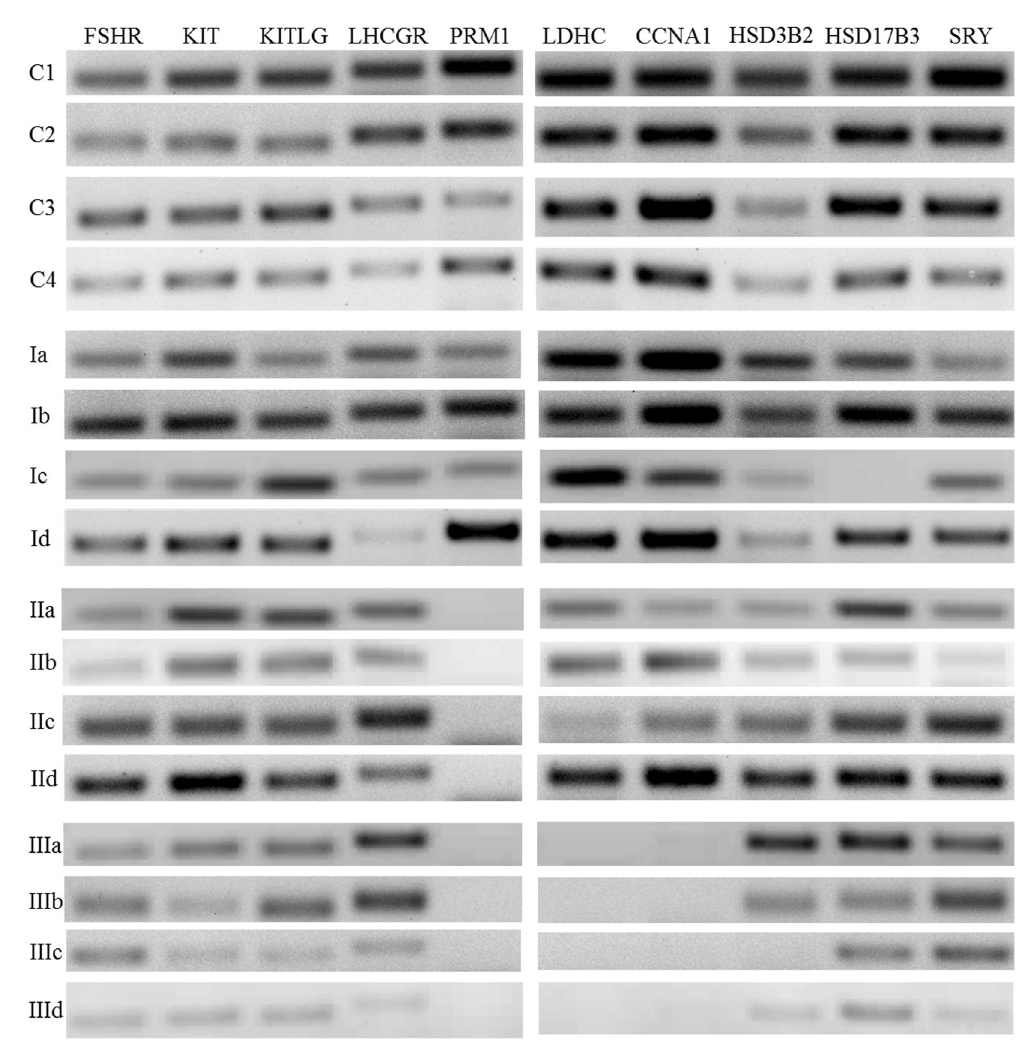
Figure 2. Expression of testicular cell specific marker genes. The expression status of the testicular cell specific markers for each representative patient samples as shown in the Fig. 1 is shown here. The total testicular RNA obtained from tissue samples was converted to cDNA by RT-PCR and the expression of the testicular cell specific markers was analyzed by semi-quantitative PCR using the specific primers. Each patient sample was analyzed individually by PCR for the expression of the testicular cell type specific markers as and when the sample was collected. Cropped images from individual gels are shown. C1–C4: control; I a-d: Group I (obstructive azoospermia, exhibiting haploid, diploid and double-diploid populations); II a-d: Group II - (NOA with meiotic arrest, exhibiting diploid and double-diploid populations); III a-d: Group III (NOA with pre- meiotic arrest, exhibiting diploid populations